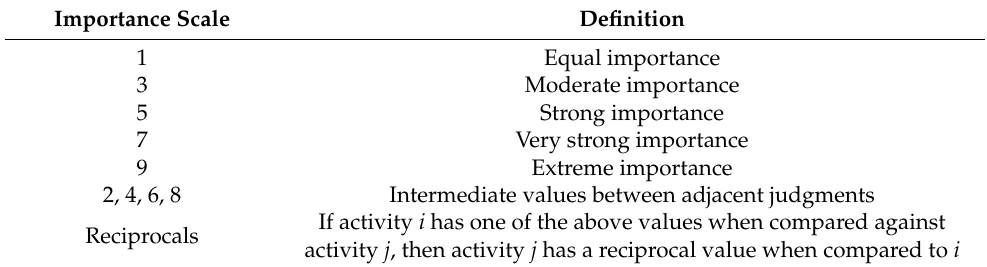
Table 1. Importance scale for making pairwise comparisons in the analytical hierarchy process (AHP) method